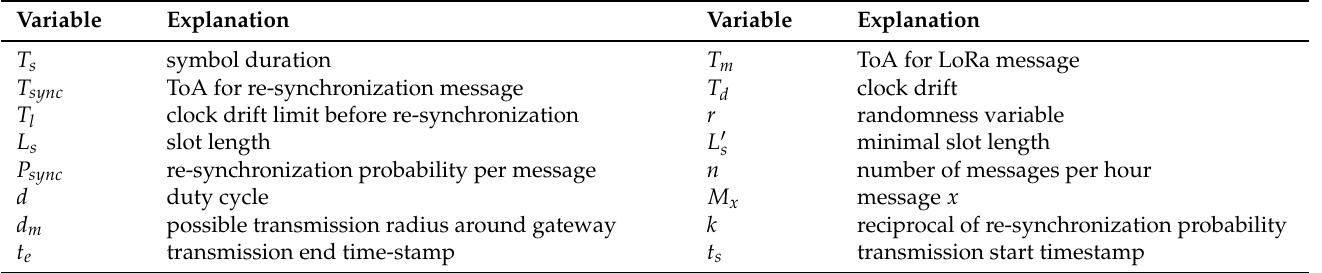
Table 1. Overview of important